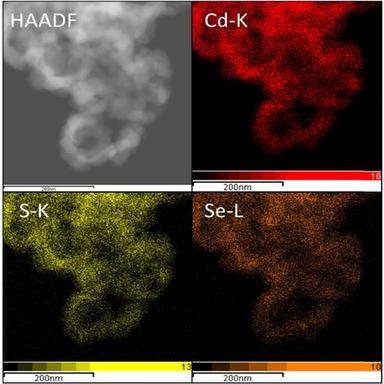
The HAADF-STEM image of CSS An 500 5 sample with EDS mapping of Cd, S, and Se elements.